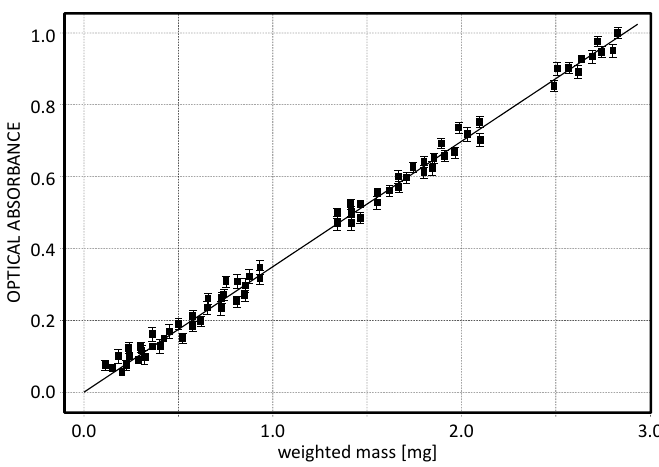
Figure 4. Calibration curve: optical absorbance (dimensionless parameter) vs. weighted mass. The experimental points have a coefficient of determination as high as 0.97.